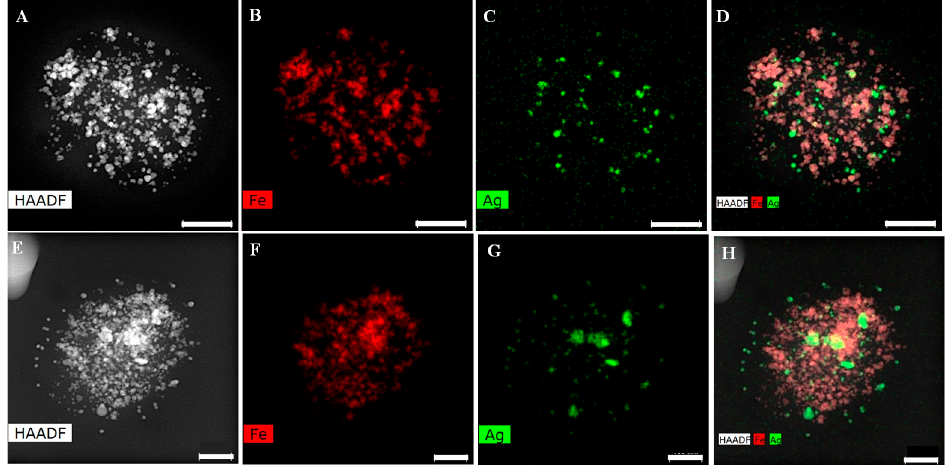
Figure 6. ( A , E ) HAADF-TEM image for hybrid PLGA@Ag 2 S@SPION_R4 and PLGA@Ag 2 S@ SPION_R5 NPs, ( B , C ) EDX elemental mapping analysis of iron and silver for hybrid PLGA@Ag 2 S@ SPION_R4 NPs. ( F , G ) EDX elemental mapping analysis of iron and silver for hybrid PLGA@Ag 2 S@ SPION_R5 NPs. ( D , H ) EDX elemental mapping of mixed iron and silver for the two hybrid colloidal systems. Scale bar is 100